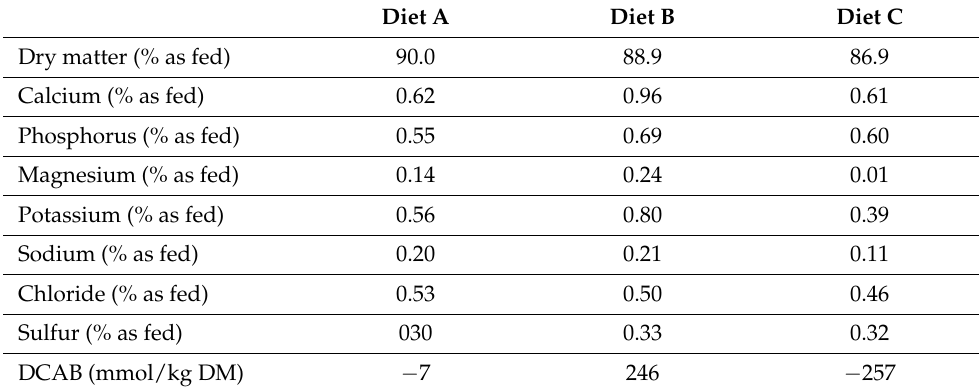
Table 1. Analyzed nutrient content and calculated DCAB of the three test diets.